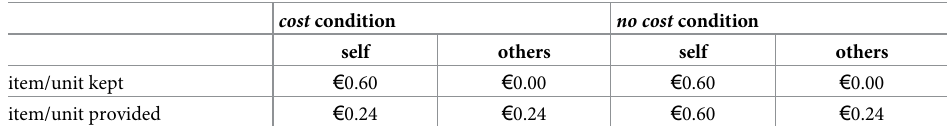
Table 7. Marginal